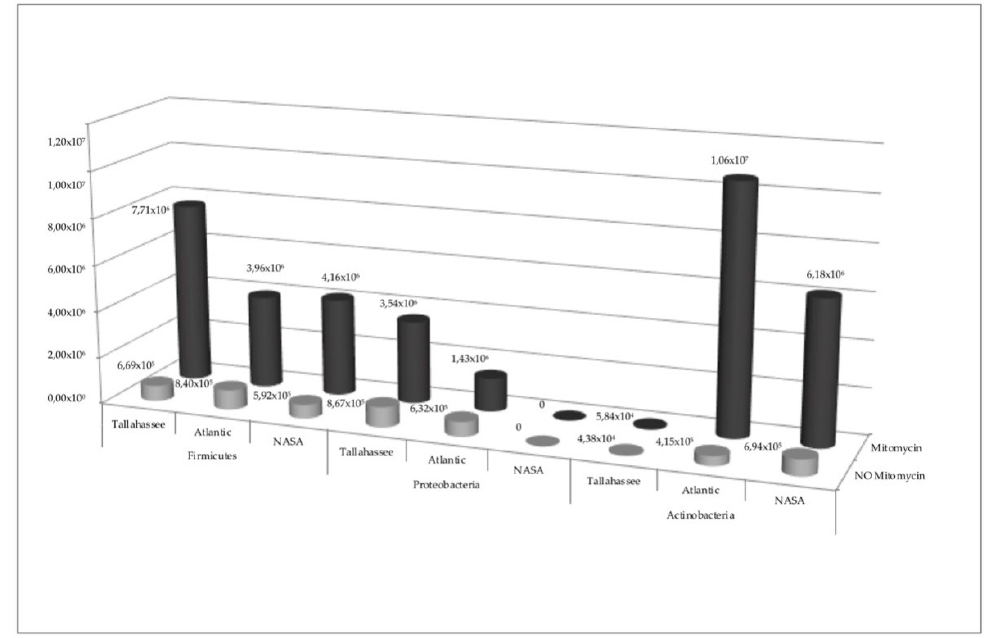
Figure 1. Average of VLP mL − 1 obtained in the mitomycin C and control wells by sites and bacterial groups.